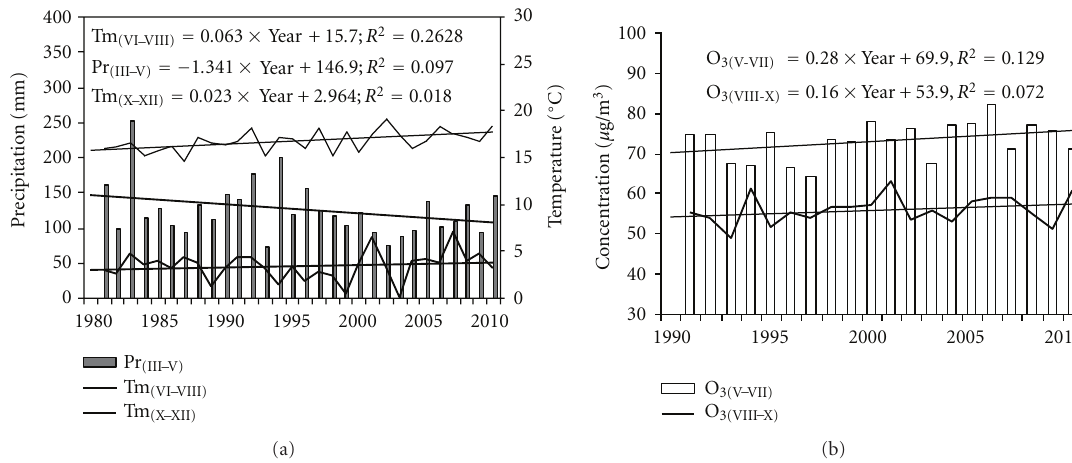
Figure 9: Variation of the key parameters limiting the growth of beech trees in